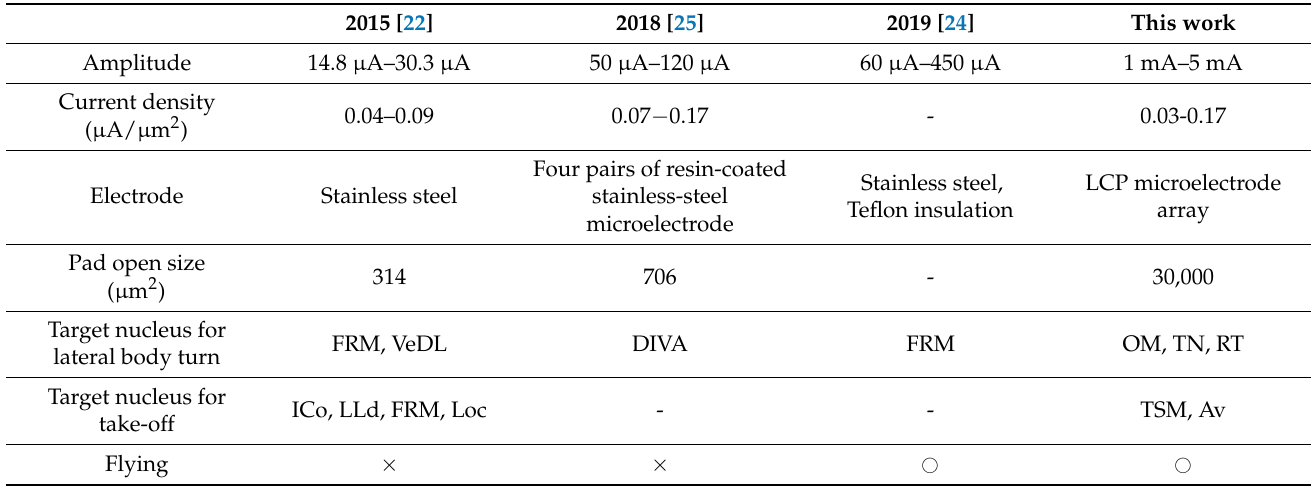
Table 2. Comparison of the stimulation parameters in this work with those in the previous